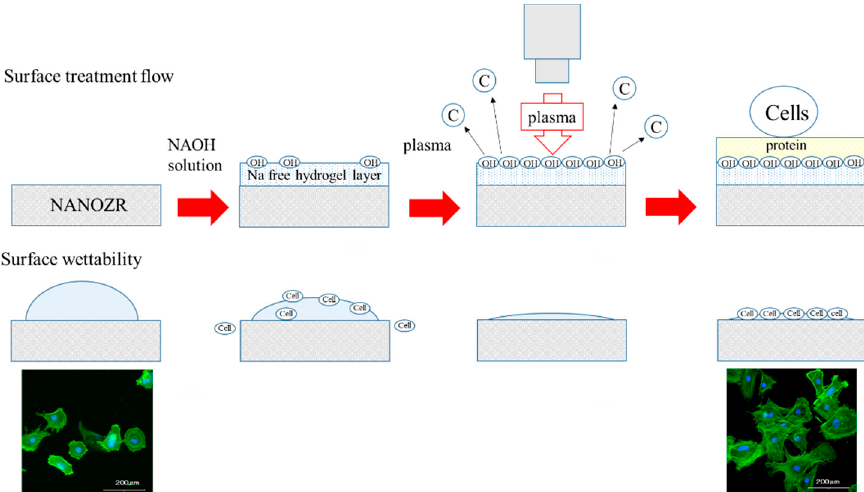
Figure 8. When the nano-ZR surface is subjected to alkali treatment, a hydrogel layer of Na ions is formed. Upon plasma treatment, formation of hydroxyl groups and removal of carbon are observed on the surface. After that, protein is adsorbed to this layer, and the cells are attached using the protein for binding.